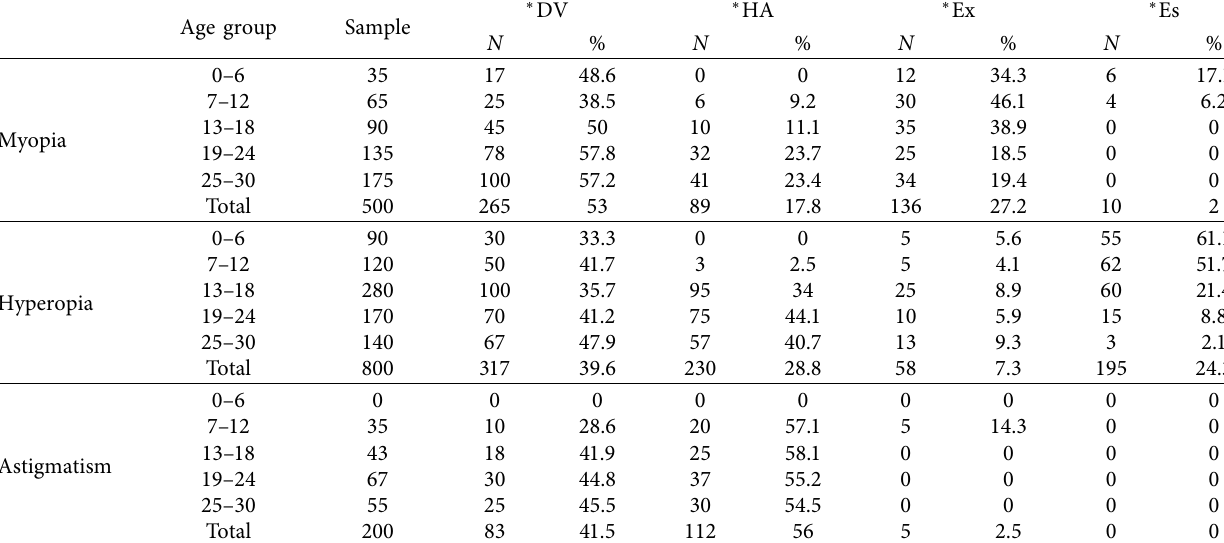
Table 2: Frequency of presenting symptoms and signs (%) for all types of refractive error according to age group ( N � 1,500). ∗ DV Age group Sample Myopia